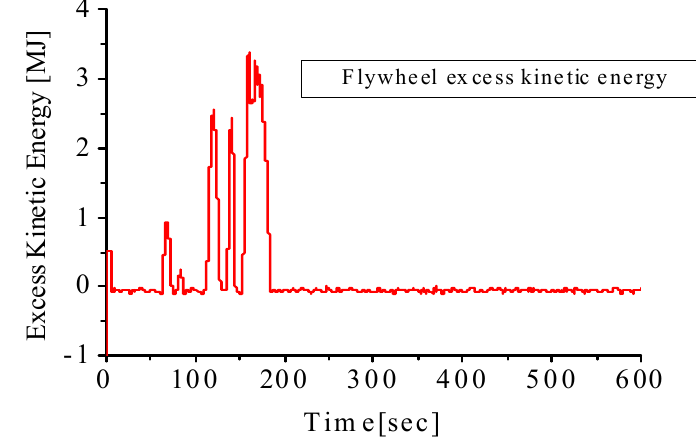
Figure 10. Excess kinetic energy.